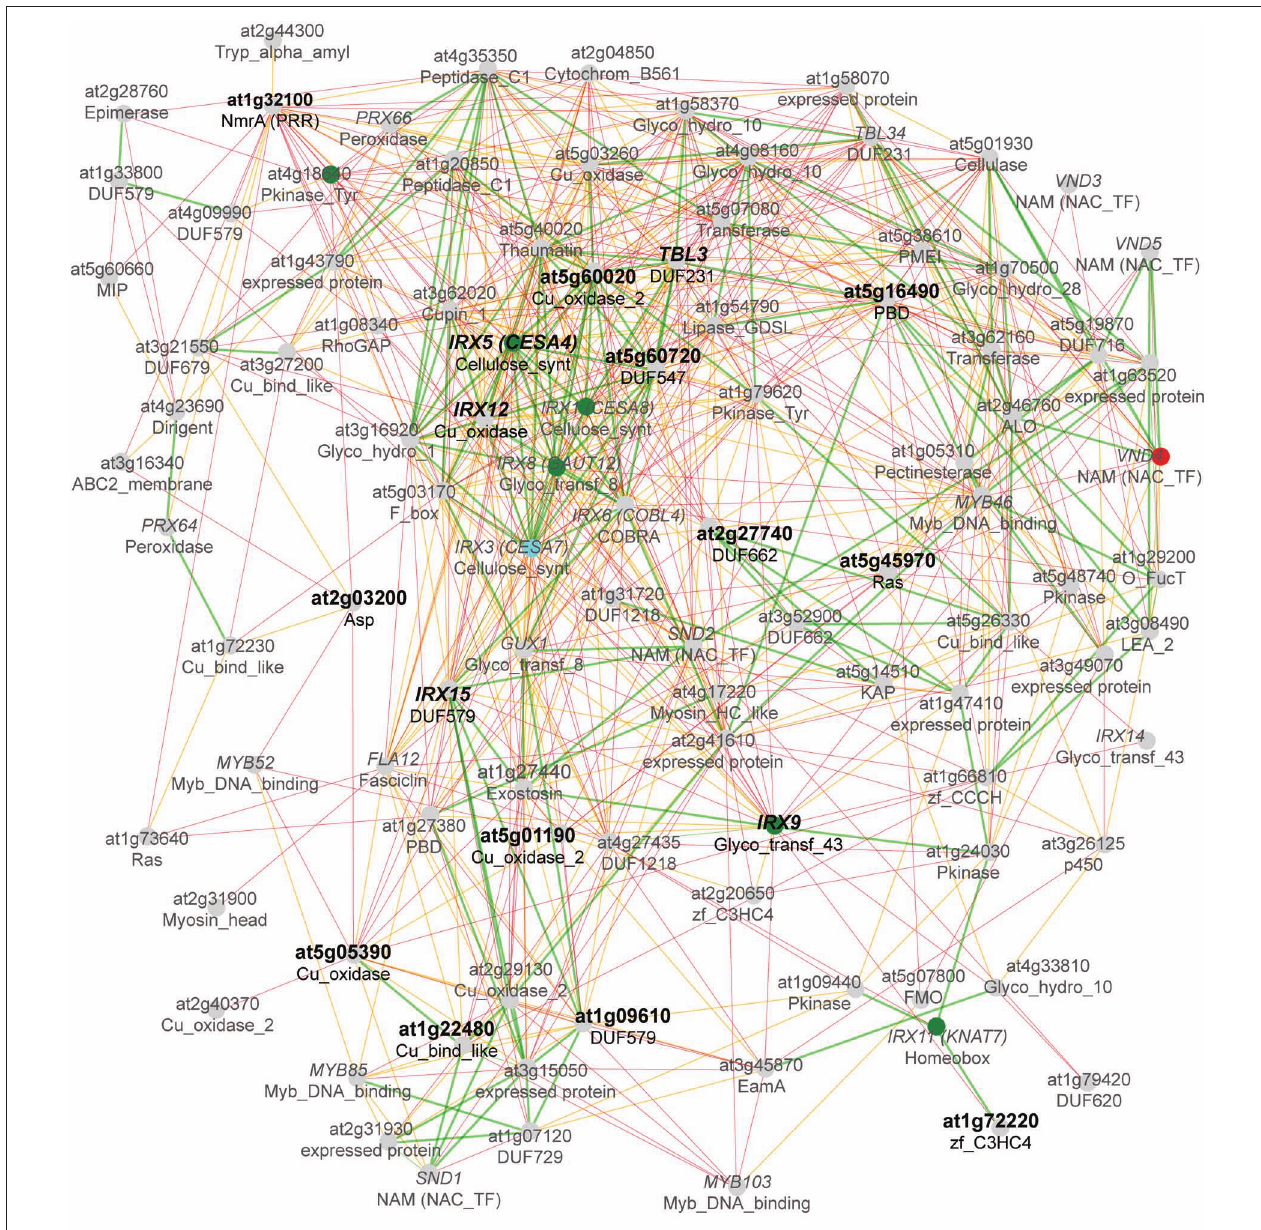
Figure 1 | Co-expression gene vicinity network for AtCESA7 (turqois). Nodes indicate individual genes, and edges indicate whether two genes are co-expressed above a certain mutual rank. Red, green, and gray nodes indicate whether mutations in the gene cause embryophytic lethality (red), any biological phenotype (green), or if no mutant phenotype currently is available (gray) according to TAIR. Green, orange, and red edges indicate a mutual rank relationship 10 (green), 10 but 20 (orange), and 20 but 30 (red),